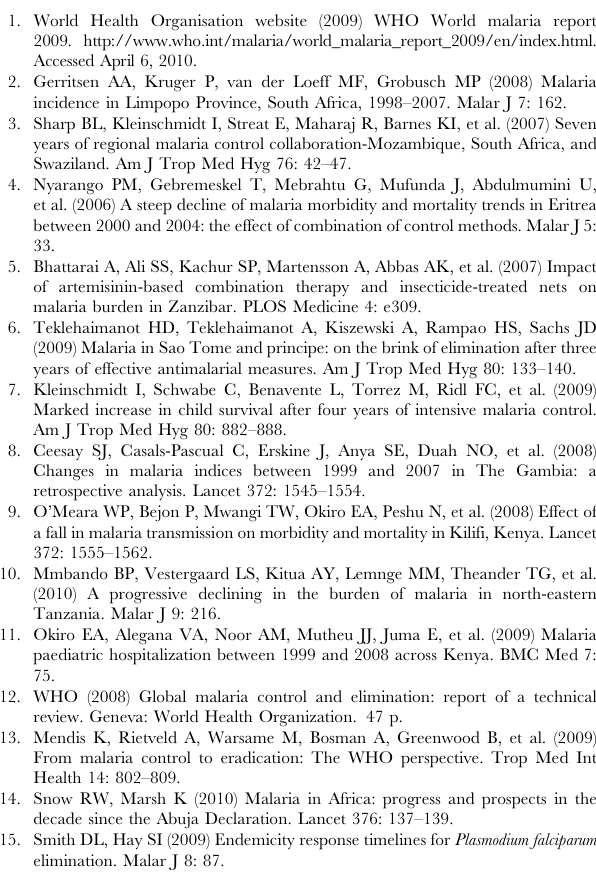
Figure 5. Serological surveys of malaria in Brefet village at the end of annual malaria seasons, December 2006 (n=211) and December 2009 (n=98). Proportions with detectable serum IgG to the MSP-1 19 antigen are plotted by age group (numbers in 2006 and 2009 respectively sampled from each age group: 0–4 years, n=35 and 17; 5–9 years, n=31 and 19; 10–14 years, n=31 and 17; 15–24 years, n=19 and 13; 25–39 years, n=46 and 17; . 39 years, 49 and 15).